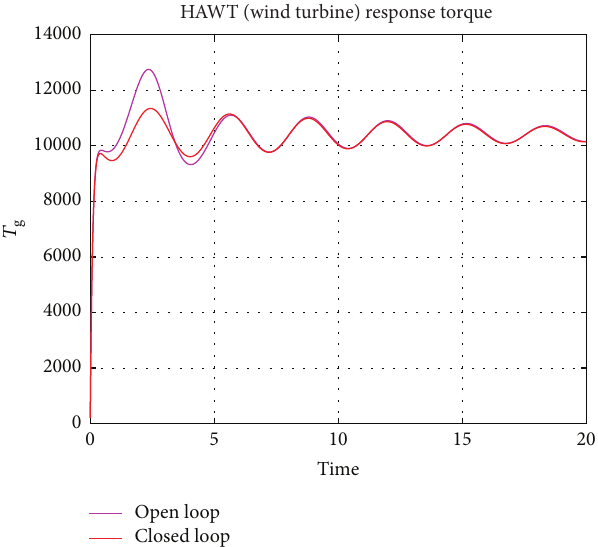
Figure 3: Horizontal axis wind turbine (HAWT) open and closed loop torque response.